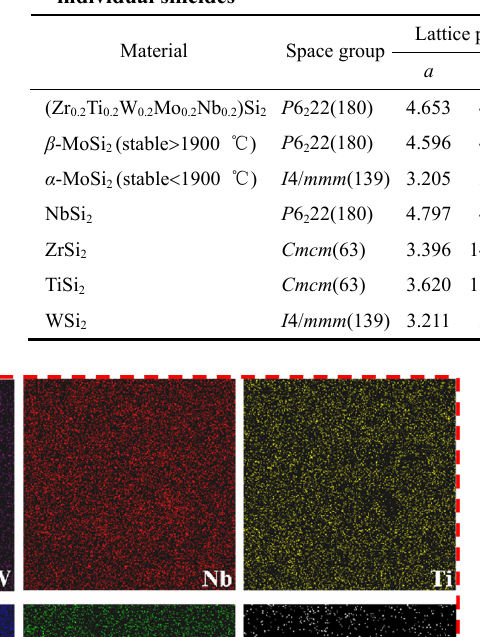
Space group and lattice parameters of